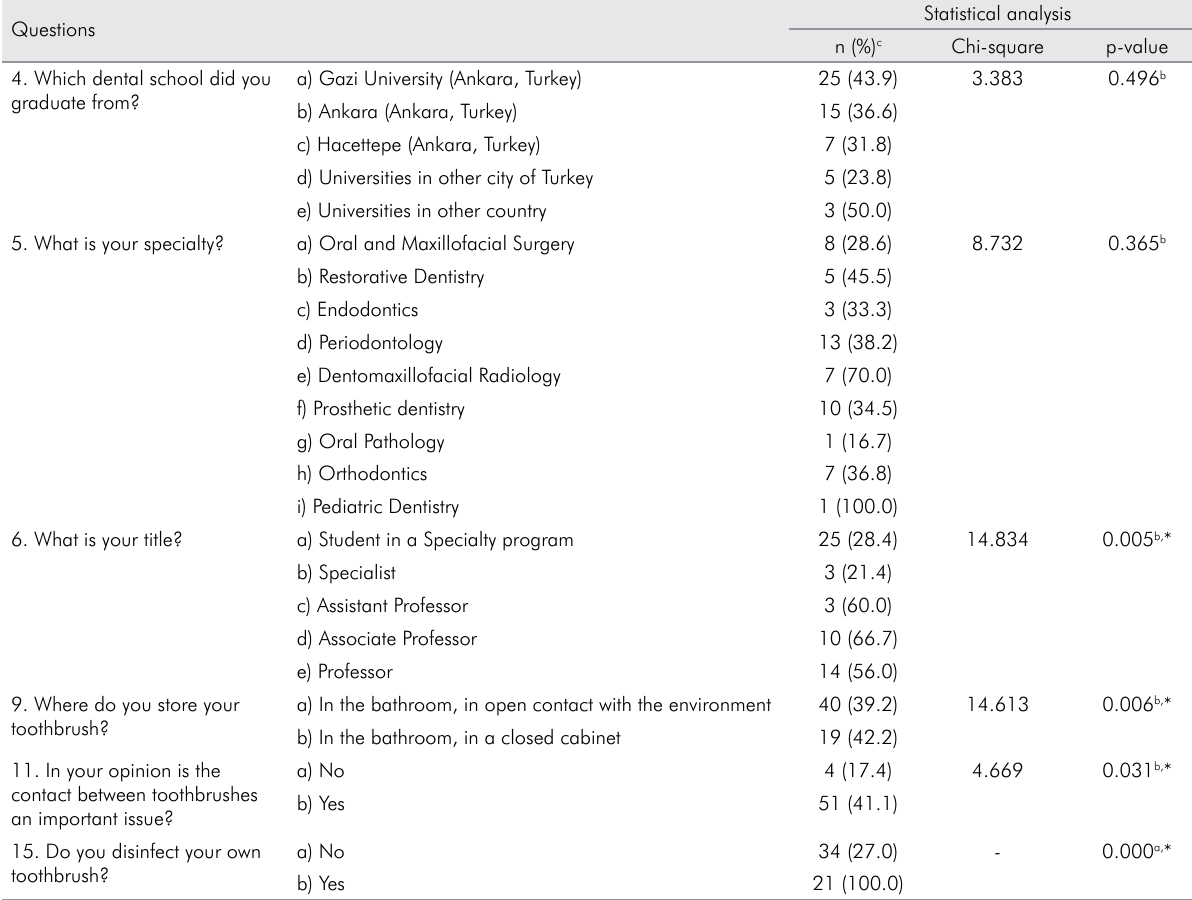
Table 3. Statistical analysis of the association of knowledge about toothbrush disinfection with other variables.